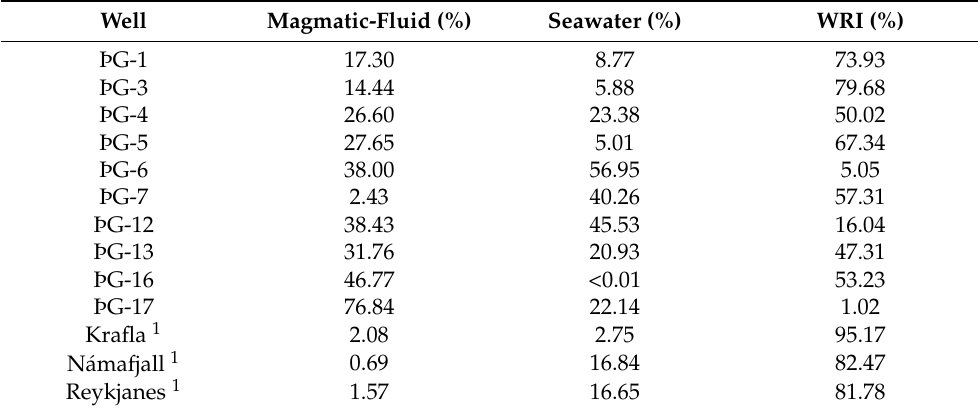
Table 2. Proportions (in %) of each source of Sr in the Theistareykir fluids. Well Magmatic-Fluid (%) Seawater